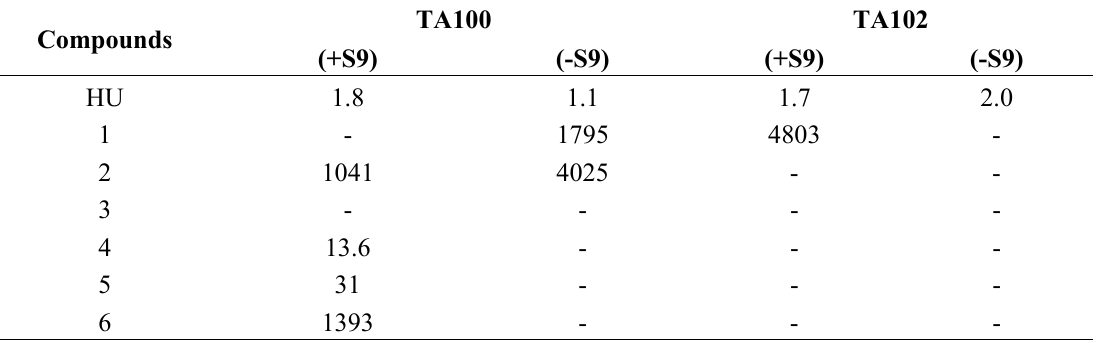
Table 2. Mutagenic potencies (rev/ μ mol) observed for HU and compounds (1–6) with positive mutagenicity (MI ≥ 2) in TA100 and TA102 Salmonella typhimurium strains in presence (+S9) and absence (-S9) of metabolic